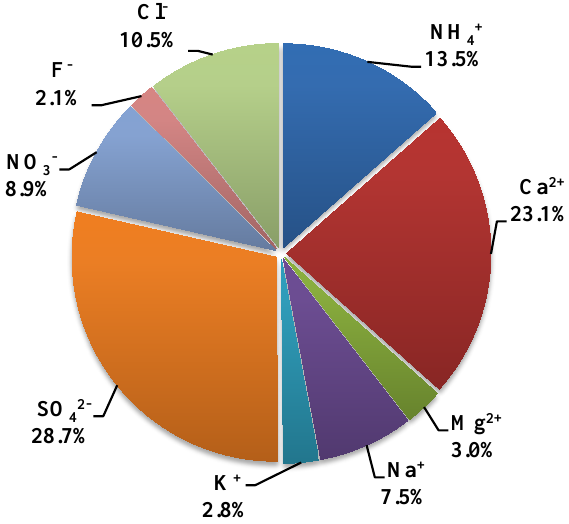
Fig. 10. Average chemical composition of precipitation in the PRD region, 2006.